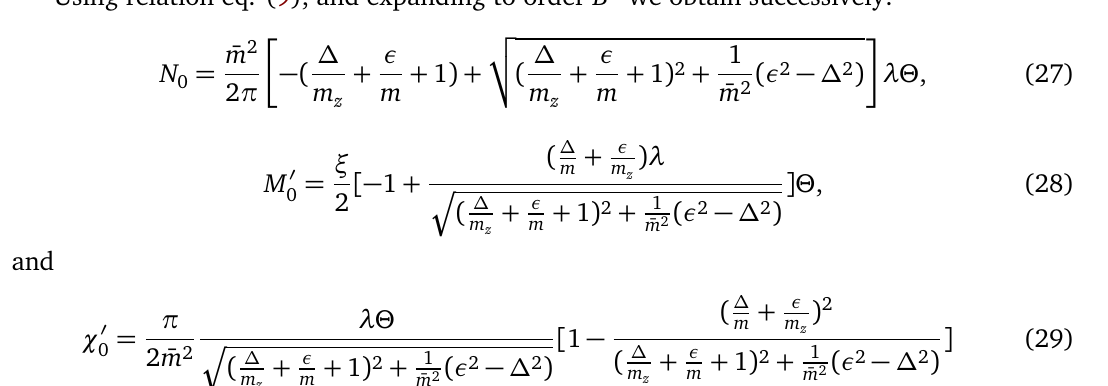
Figure 3: 2D semiconductors. (a) Dispersion relation in zero field: energy (cid:200) (cid:128) (cid:138) 2 ε ( k ) = k 2 + λ ∆ + k 2 [ in units of ∆ ] as a function of the wavevector k [ in units k 2 + λ 2 m 2 m z ∆ = 1 > ∆ = 0.5. (b) Landau levels: energy ε of ∆ ] for 2 m 2 m z v 2 ∆ 2 ] for different values of the Landau index ¯ n = n + 1 + λξ of the field B [ in units of 4 π for λ = + and ¯ n = 0,1,2,3 for λ = − (here we consider the ξ = + valley). (c) IDoS N ∆ ] , derivative of the magnetization M (cid:48) line, in units of ¯ m 2 π [ dotted blue line, in units of π the susceptibility χ (cid:48) 0 = 2 (cid:112) = 1 (cid:112) of ∆ ] for ¯ m , ¯ m and ¯ m ∆ = 1. m z m 3 3 (cid:112) = 2 π B = = 2 π B where ω , ω 4 π B , ¯ n = n + 1 , ω v z 0 m m z